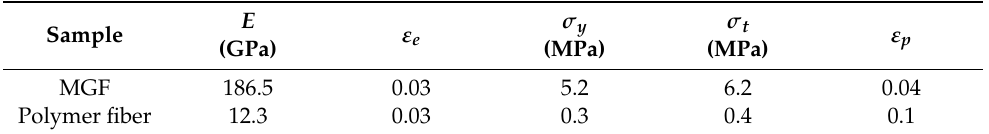
Table 1. The tension test results of the MGF and polymer fiber, i.e., Young’s modulus ( E ), elastic